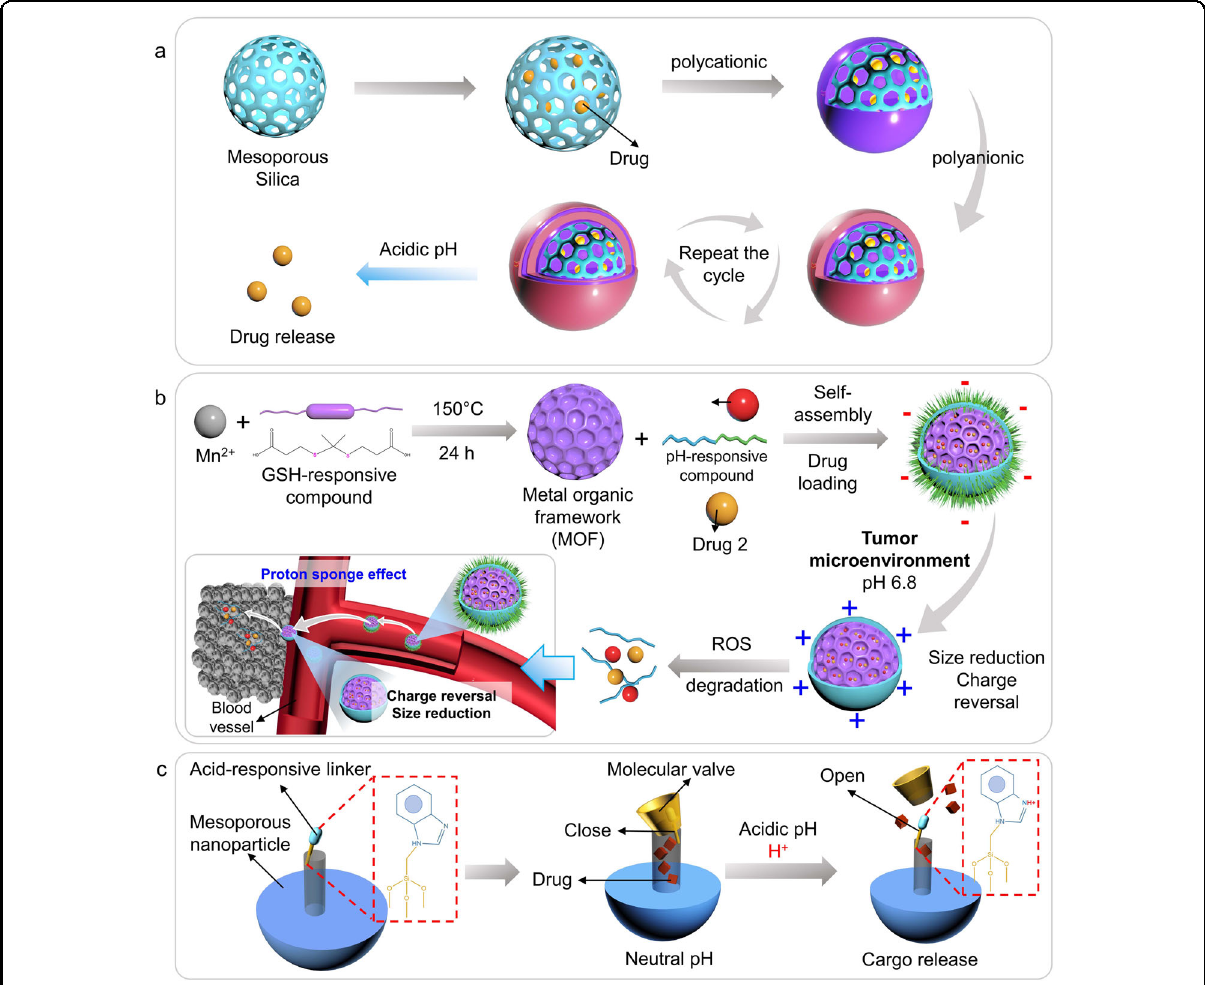
Fig. 10 Modi fi cation of mesoporous nanoparticles to achieve the pH-triggered release of cargo. a Layer-by-layer assembly. b Size shrinkage and charge reversal triggered by the acidic tumor microenvironment. c pH-responsive gatekeepers consisting of stalks and nanovalves on mesoporous